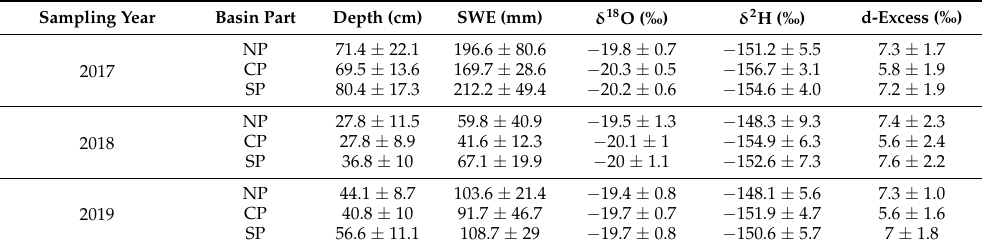
Table 2. Means and standard deviations of the bulk snowpacks SWE, depth, and isotopic composition, averaged over 2017–2019 and northern (NP), central (CP), and southern (SP) parts. Sampling Year Basin Part Depth (cm) SWE (mm) δ 18 O (‰) δ 2 H (‰) d-Excess (‰)